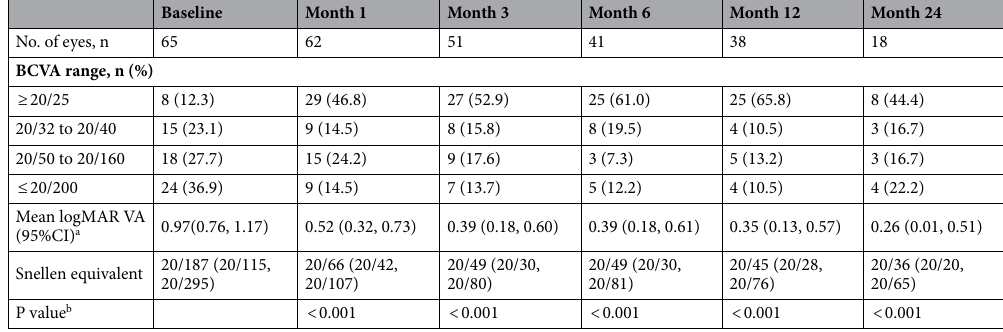
Table 3. Visual acuity outcomes after treatment with systemic antibiotics. BCVA : Best-corrected visual acuity; logMAR : log of the minimum angle of the resolution. a Derived from mixed effect random-intercept linear regression model. b Compared to baseline.